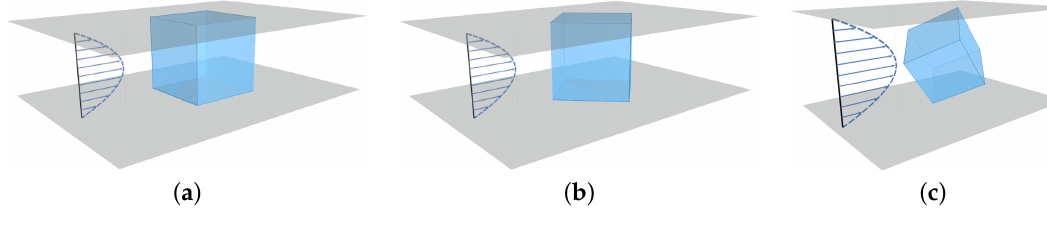
Figure 3. Test setups for the optimization-based boundary treatment in the LB solver. The blue region corresponds to the Cartesian grid-based computational domain used by the LB solver, the direction of the parabolic flow profile is sketched on the left side of the gray plates. ( a ) Setup Normal ; ( b ) Setup Diagonal ; ( c ) Setup Bi-Diagonal